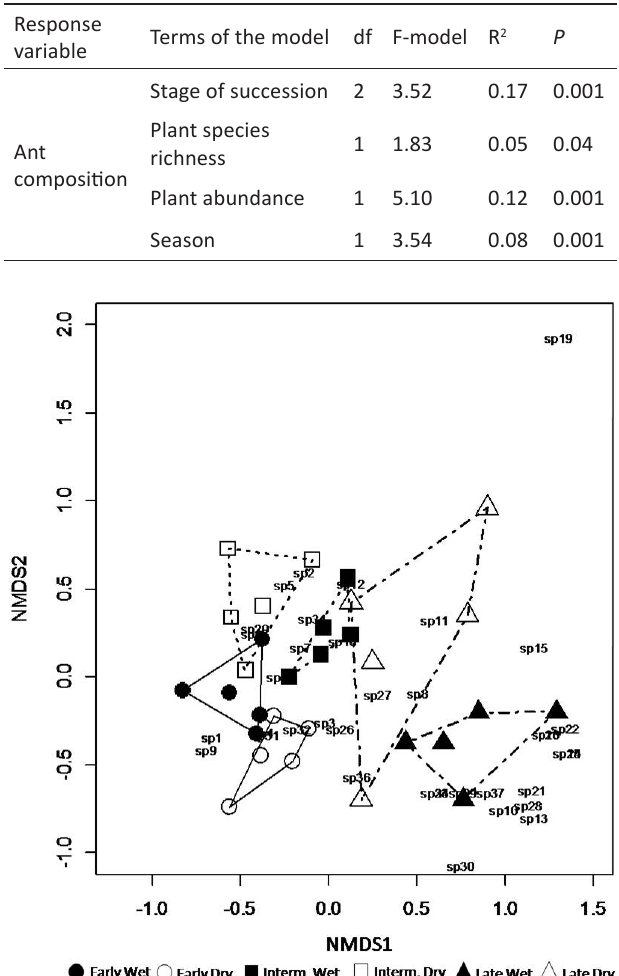
Table 2 - PERMANOVA main tests for differences in assemblage composition of arboreal ants among successional stages, season and habitat structure (plant species richness and density), in a semiarid Caatinga, state of Sergipe, Brazil.